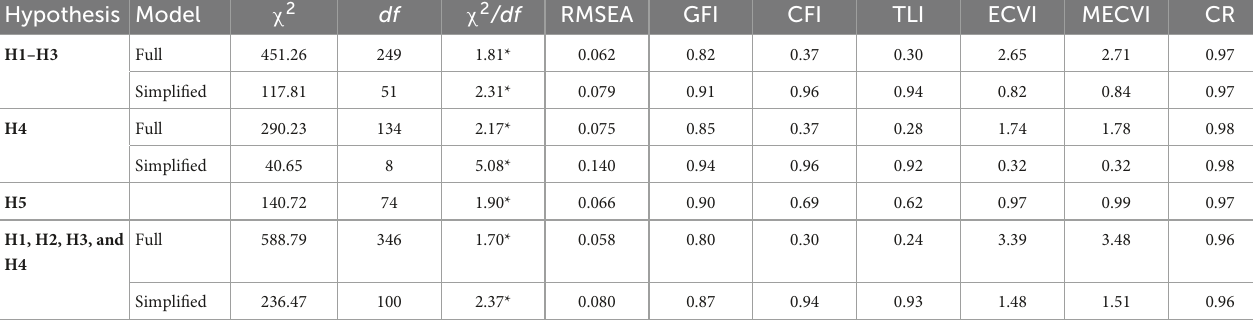
TABLE 2 Fit indices of the tested SEM